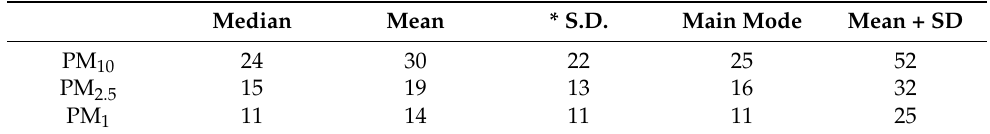
Table 3. The statistical summary for mass concentrations of PM 10 , PM 2.5 , and PM 1 for the experiment period of August 2007~February 2012 ( µ g/m 3